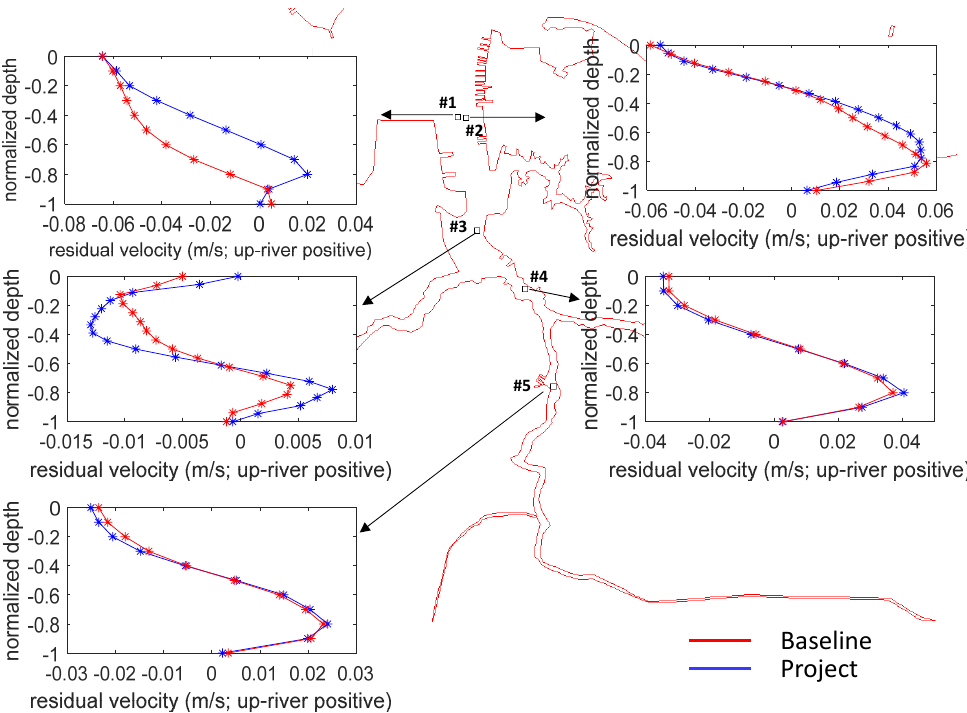
Figure 14. The two-layer exchange flow patterns at five stations in the Elizabeth River. Note that Station #1 is over the original shallow shoal, which is dredged to similar depths as the central channel in the project scenario; other stations are all in the original central channel, which is deepened after the project.